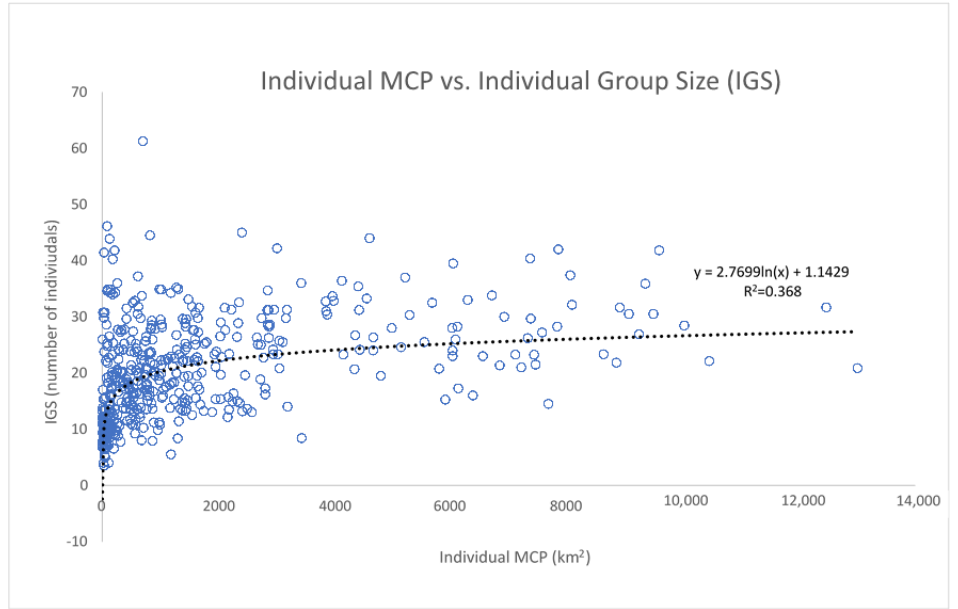
Figure 12. The correlation between the individual group size (IGS) and the individual MCP is statistically significant according to an ANOVA test (F = 279; p -value < 0.01). Cluster A was excluded from the analysis (see above). Additionally, the (logarithmic) relationship between the average group size and the average MCP across the clusters was found to be statistically significant ( p -value < 0.01), even if only four points were displayed in the graph (see Figure 13).